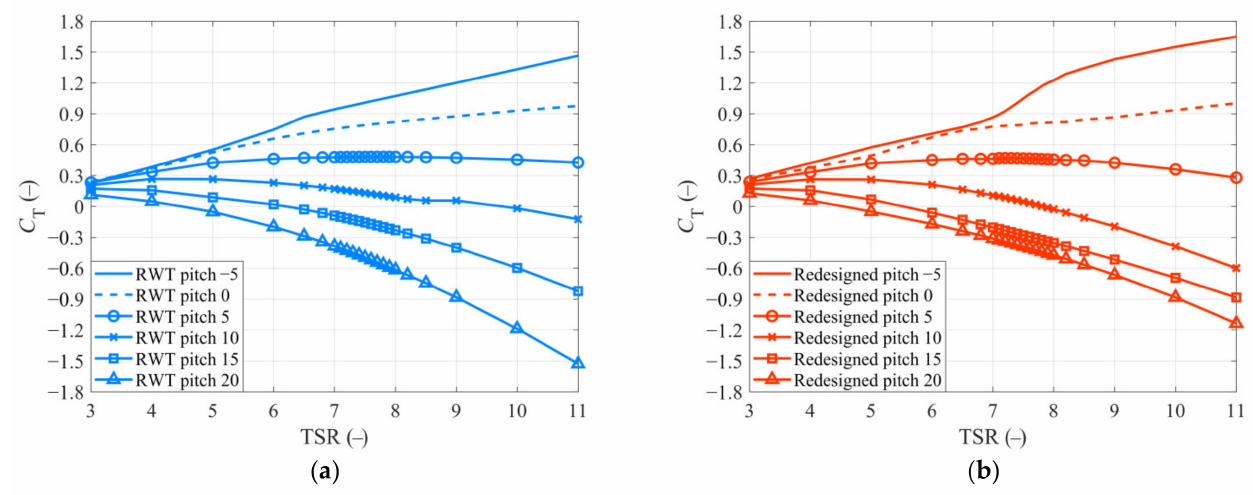
Figure 8. The C T -TSR curves with different pitch angles. ( a ) RWT blade. ( b ) Redesigned